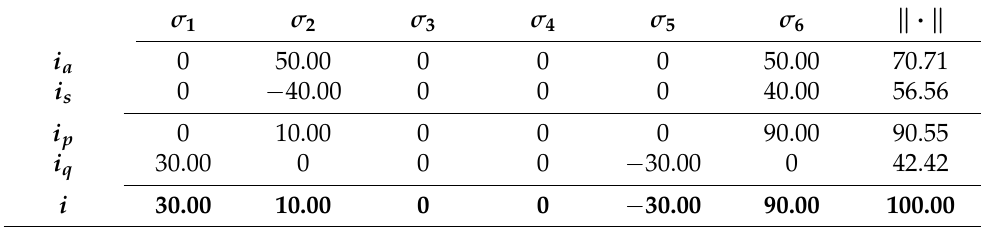
Table 2. Current decomposition for the circuit in Figure 2 and C = 2/7